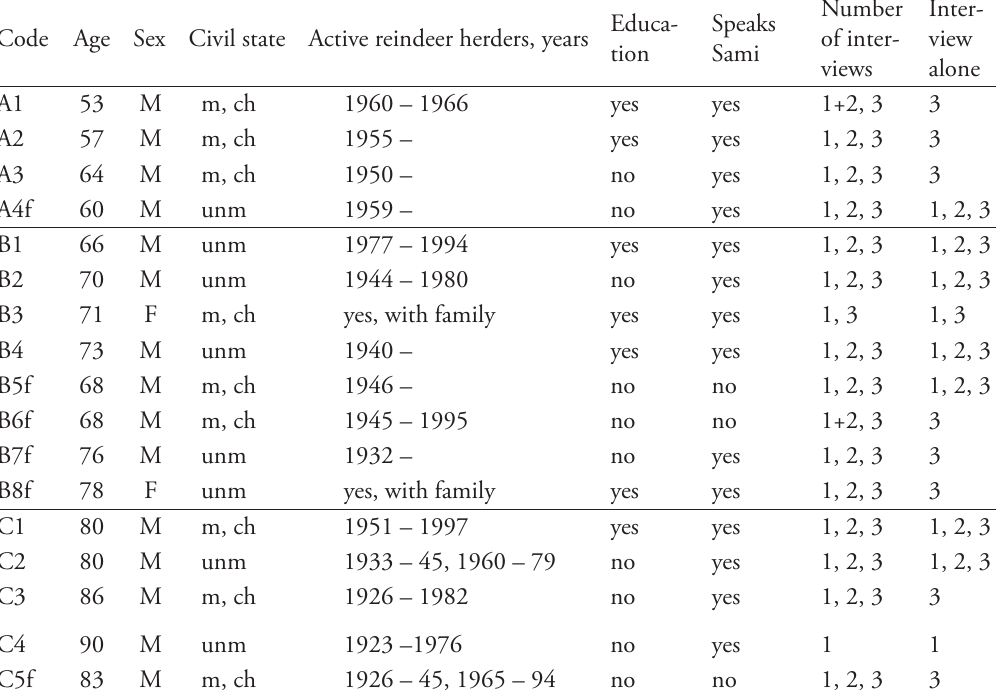
Table 1. Background information about the interviewed reindeer